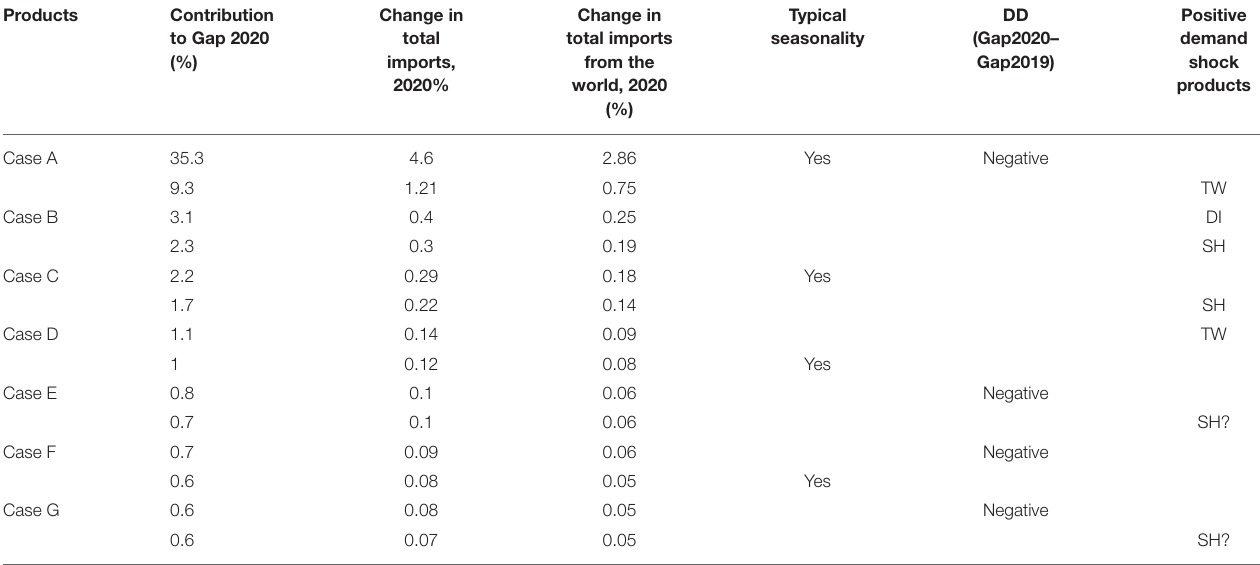
TABLE 6 | Measurements of Imports for Chinese strategic emerging industries. Products